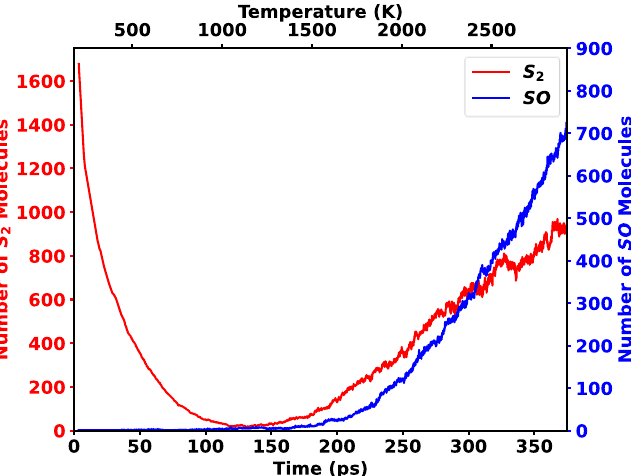
Figure 7. Change in the number of S 2 molecules and the formation of SO molecules up to 375 ps in the vacuum region of the simulation box. 951 molecules of S 2 remained and 716 molecules of SO were formed after 375 ps.